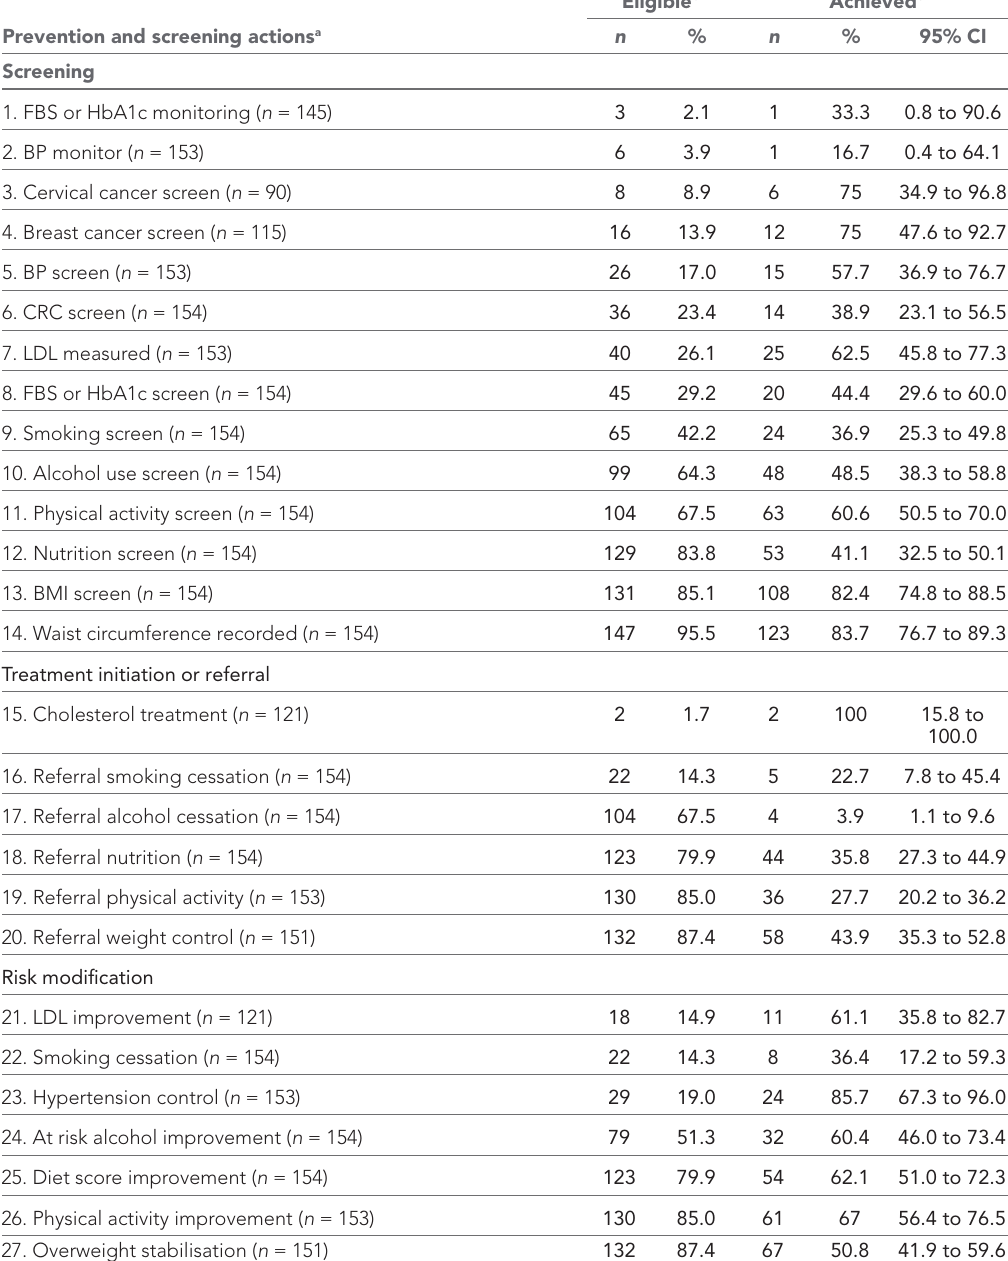
Table 3 Eligibility and achievement of individual prevention and screening actions Prevention and screening actions a